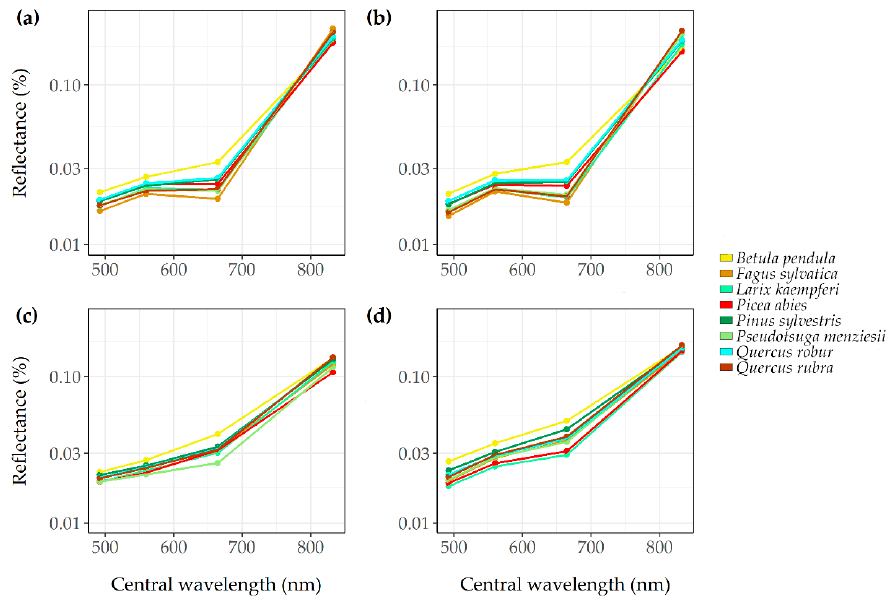
Figure A4. Mean spectral reflectance of the eight most common tree species on the Veluwe for the blue (B02), green (B03), the red (B04), and the near infrared (B08) Sentinel-2 bands. The spectral reflectance is calculated for each season: summer ( a ), autumn ( b ), winter ( c ), and spring ( d ).